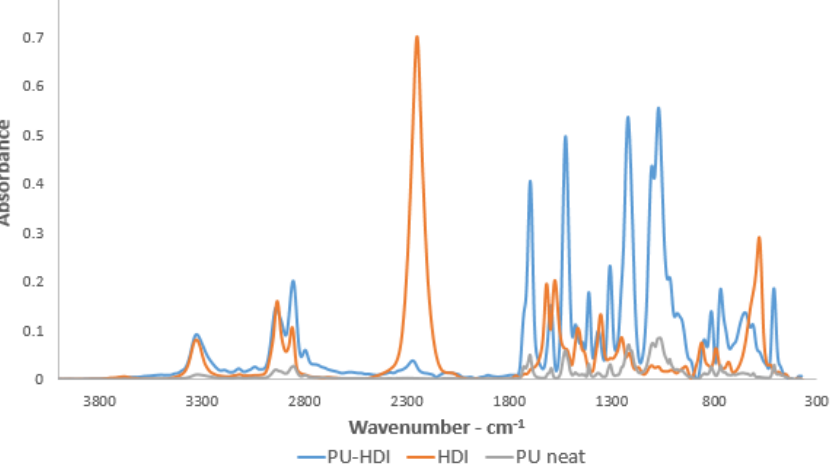
Figure 4. ATR-FTIR spectra of functionalized PU surface (PU-HDI); PU neat and HDI